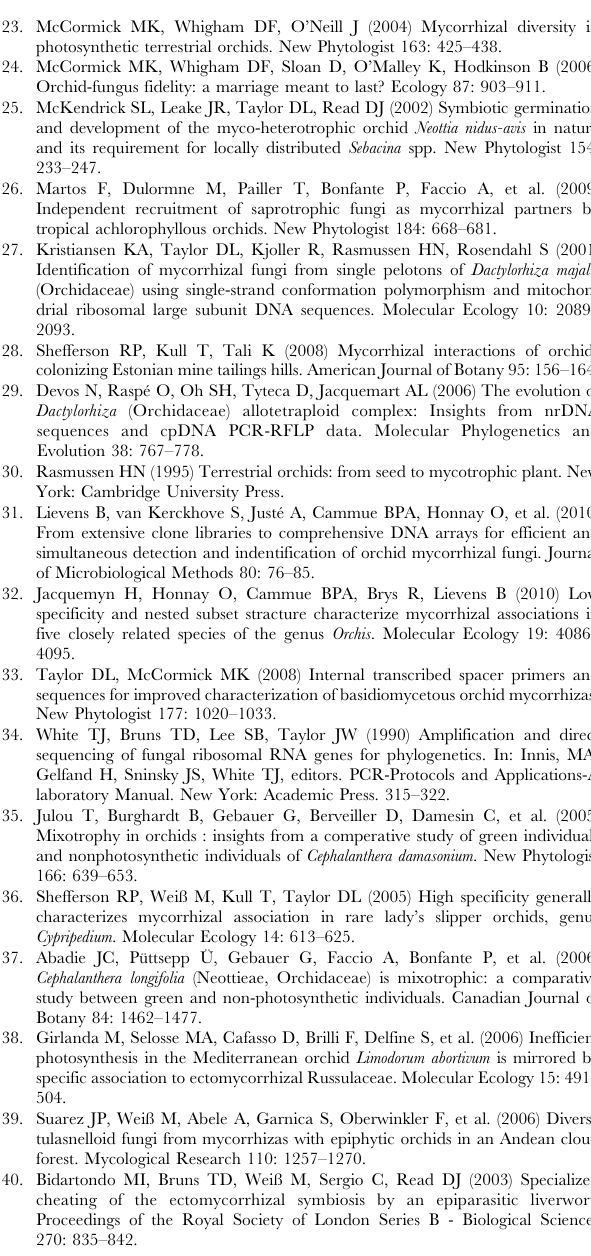
Figure S1 Location of sample sites of mycorrhizal fungi for DNA sequencing in five Dactylorhiza species in Belgium. Figure S2 Rarefaction analysis performed on the in- ternal transcribed spacer (ITS) sequence data obtained from the clone libraries for five Dactylorhiza species (1334 sequences), using a 95% sequence similarity threshold value. Table S1 Detector oligonucleotides used in this study to detect ten different operational taxonomic units